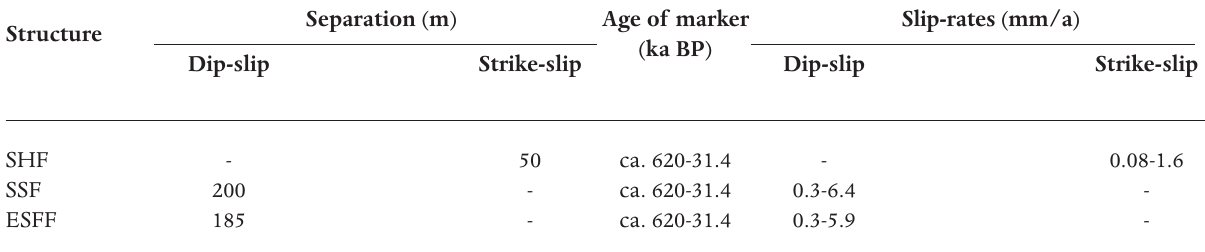
Table 4. Slip-rates for Graciosa faults.